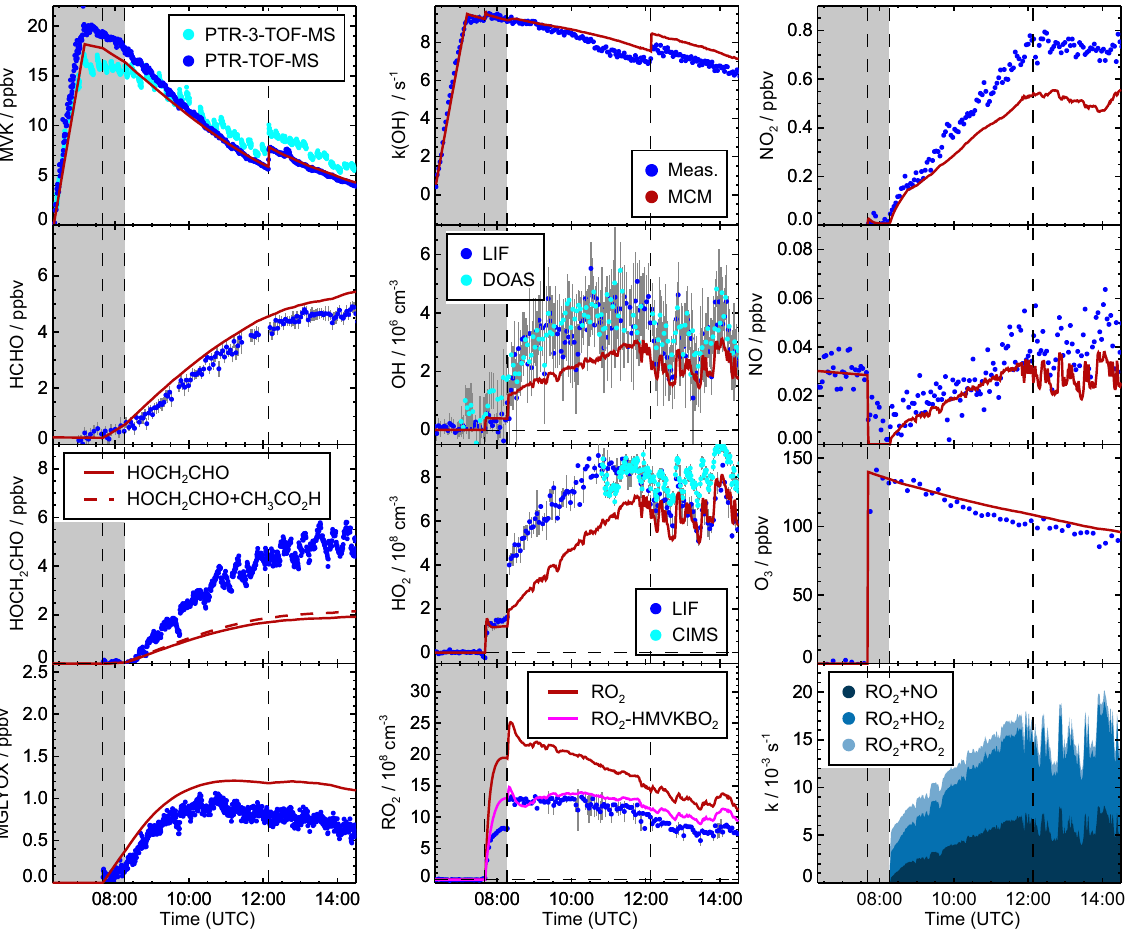
Figure 3. Time series of radicals, inorganic and organic species during the MVK photooxidation at low NO (23 May 2017) together with results from model calculations applying MCM. Dark shaded areas indicate the time before opening the chamber roof and vertical dashed line times when trace gases were injected into the chamber. RO 2 loss rates (most lowest right panel) are calculated from modelled HO 2 , RO 2 and NO